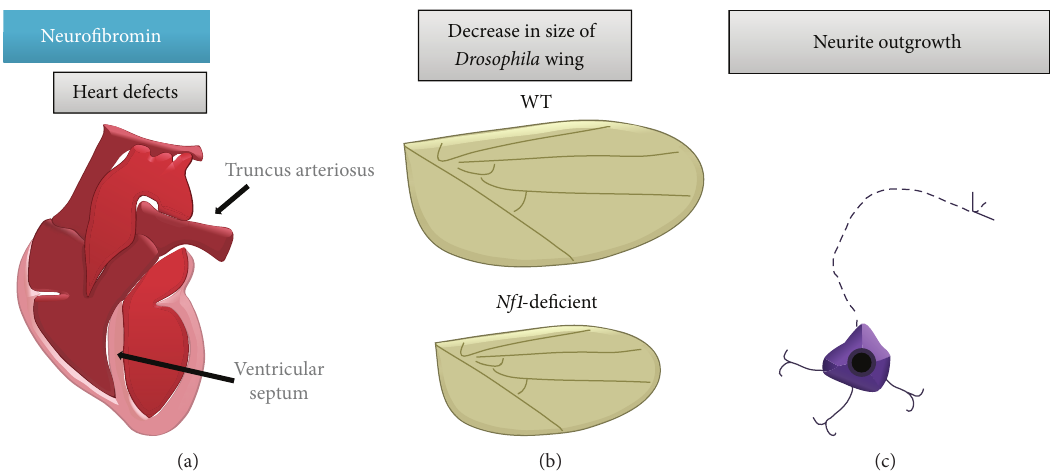
Figure 4: Neurofibromin function during normal development. Neurofibromin is important for proper (a) heart vessel development, (b) Drosophila wing formation (cell proliferation and size), and (c) axon extension and neuron